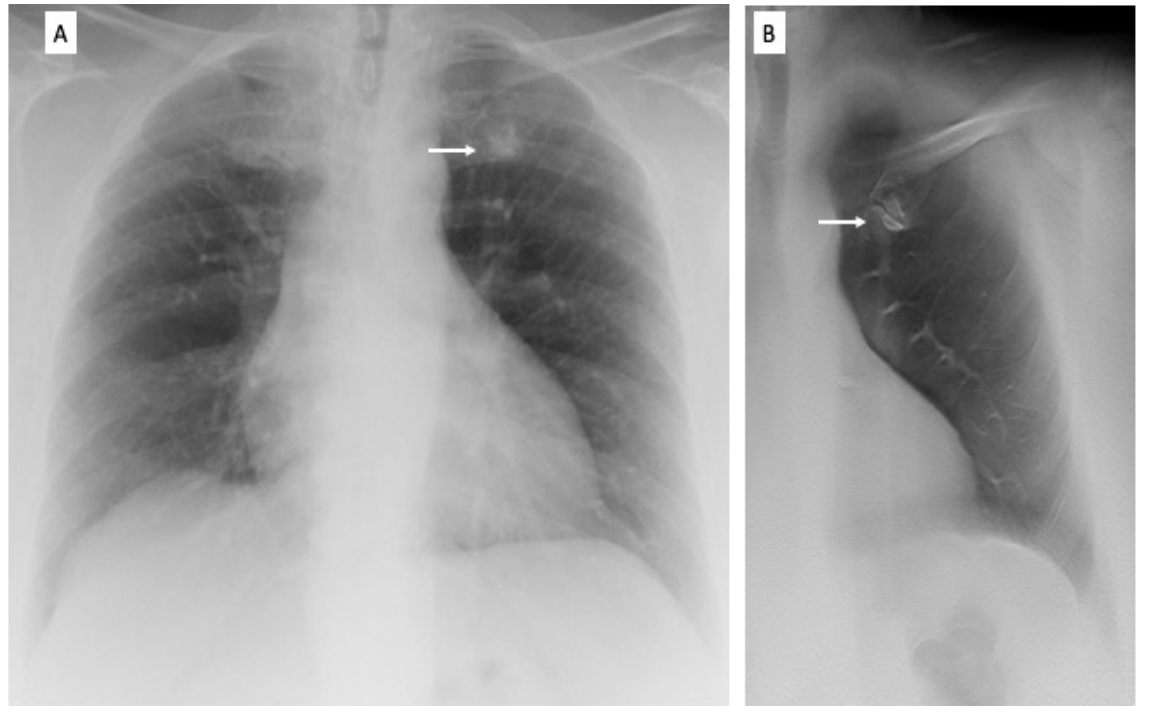
Figure 3. Pre-operative X-ray of a 72-year-old woman for skin melanoma. ( A ) Posteroanterior chest radiography in the upright position shows one suspected pulmonary nodule in the left apex (arrow). ( B ) Digital tomosynthesis image clarifies that the same opacity corresponds to a costal arthrosic hypertrophy of the anterior arch of the first left rib (arrow). Readers provided a confidence score of 1. Table 1. Radiologic patterns and final diagnoses of all DTS findings.